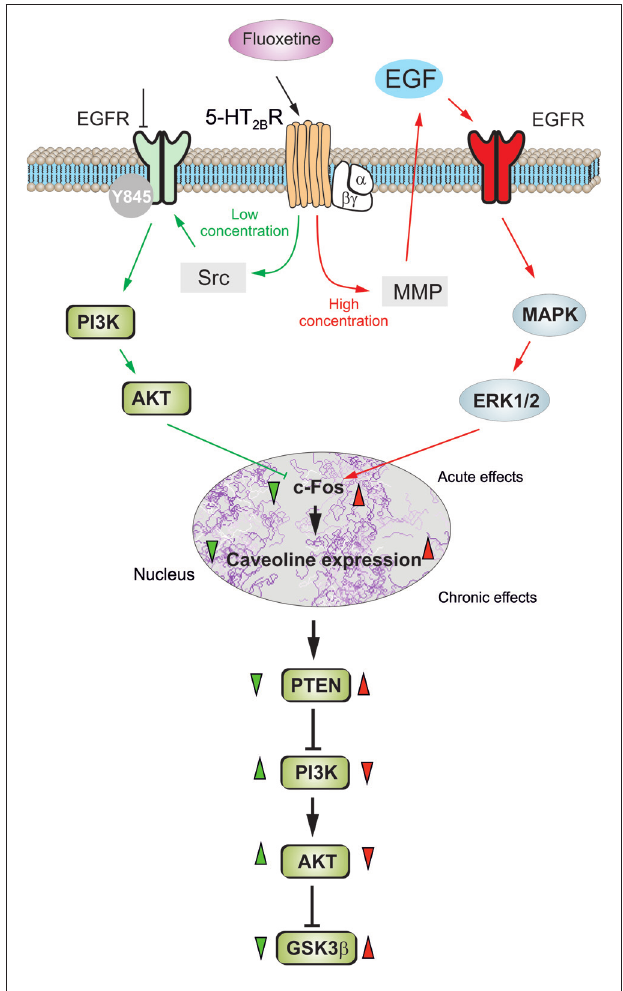
FIGURE 7 | Schematic illustration of biphasic concentration-dependent regulation of Cav-1 gene expression and GSK-3 β activity by fluoxetine in astrocytes. Acute treatment with fluoxetine at low concentrations (green arrows) stimulates Src which phosphorylates EGFRs and activates PI3K/AKT signal pathway. The AKT phosphorylation by fluoxetine at low concentrations inhibits cFos gene expression, and subsequently decreases Cav-1 gene expression (chronic effects) that in turn, decreases membrane content of PTEN, induces phosphorylation and stimulation of PI3K and elevates glycogen synthase kinase 3 β (GSK-3 β ) phosphorylation thus suppressing its activity. At higher concentrations fluoxetine (red arrows) stimulates metalloprotinase and induces shedding of growth factor which stimulates EGFRs and activates MAPK/ERK 1 / 2 signal pathway. The ERK 1 / 2 phosphorylation by fluoxetine at high concentrations stimulates cFos gene expression, and subsequently increases Cav-1 gene expression (chronic effects), that acts on PTEN/PI3K/AKT/GSK-3 β in an inverse fashion (Summary of results in